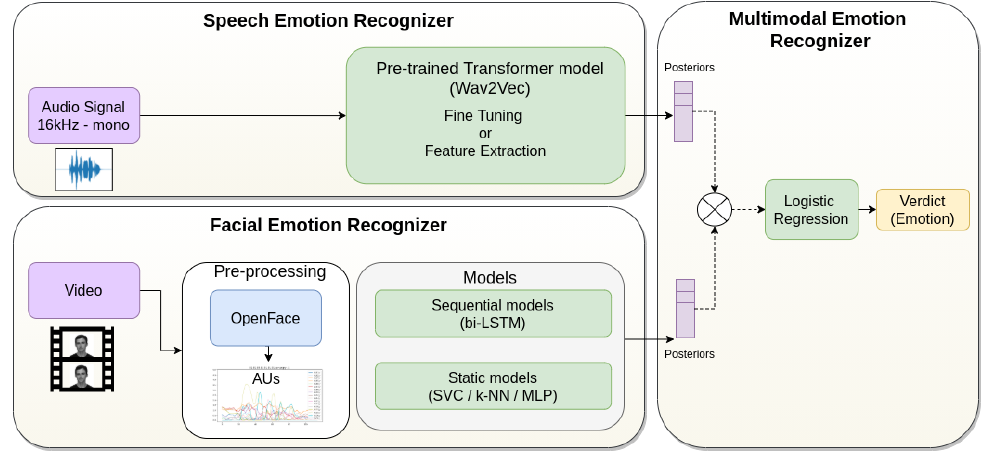
Figure 1. Block diagram of the implemented systems. The figure represents the analyzed models from the existent family of sequential models, static models, and